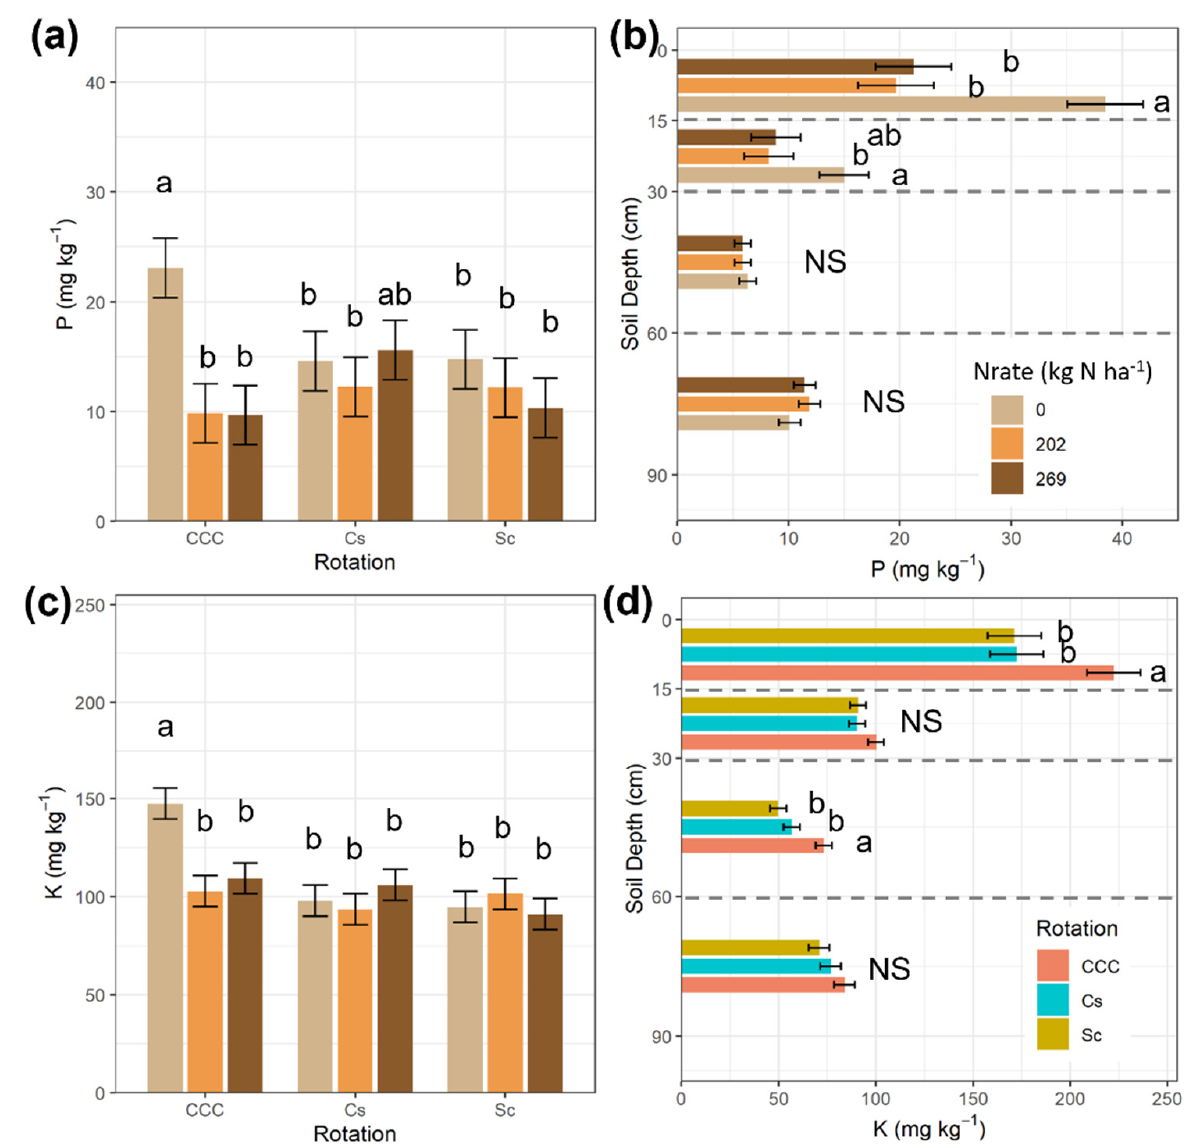
Figure 6. ( a ) Mean soil available P (mg kg − 1 ) by crop rotation and N fertilization rate, and ( b ) by depth and N fertilization rate, and ( c ) mean soil K (mg kg − 1 ) by crop rotation and N fertilization rate, and ( d ) by depth and crop rotation. In all cases, bars show the mean values and error bars represent the standard error of the treatment means. The placement of bars within each depth range (0–15, 15–30, 30–60, and 60–90; cm) does not signify differences in sampling depth. The N fertilization rates were 0, 202, and 269 (kg N ha − 1 ). Crop rotations are continuous corn (CCC), and the corn-soybean rotation (CS) as corn Cs and soybean (Sc) phase, respectively. Within each panel and depth, means followed by the same lowercase letters are not statistically different ( α = 0.05). Lack of statistically significant differences among treatment means within the same depth is indicated by “NS”.